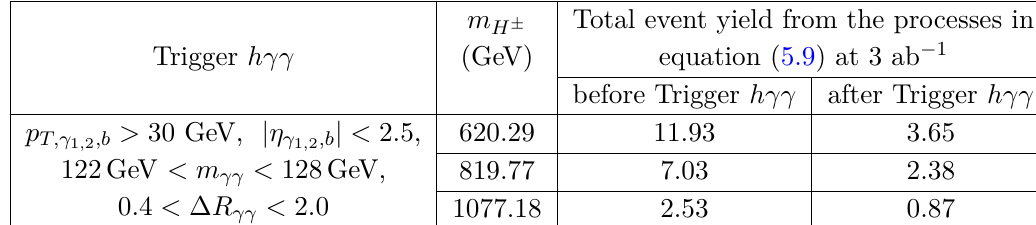
Table 34. Summarising the trigger cuts (additional cuts applied on | η | < 2 . 5 ) and the event yield at 3 ab − 1 in the γγ + LLCP category. e χ ± 1 m H ± βcγτ of Fraction of events after Trigger hγγ in % within (GeV) e χ ± (cm) 0 − 3 mm 3 − 30 mm 30 mm – 10 cm 10 − 30 cm 30 − 100 cm > 100 cm 1 620 . 29 27 . 66 0 . 89 Table 35. The fractional number of events which decay at different parts inside tracker for the 4 F production process with H ± → χ ± χ 0 in γγ + LLCP e 1 2 e